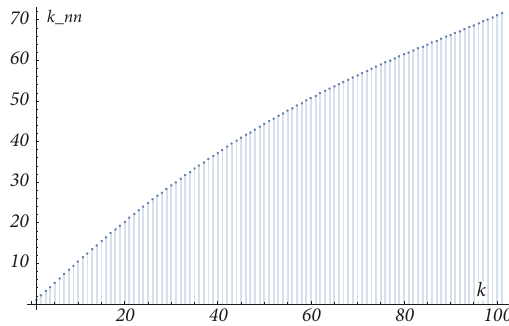
Figure 3: Function 𝑘 𝑛𝑛 for an assortative network as in Section 3.3 with 𝛼 = 1/2 , 𝑛 = 101 ( 𝑁 ≃ 10 4 ).